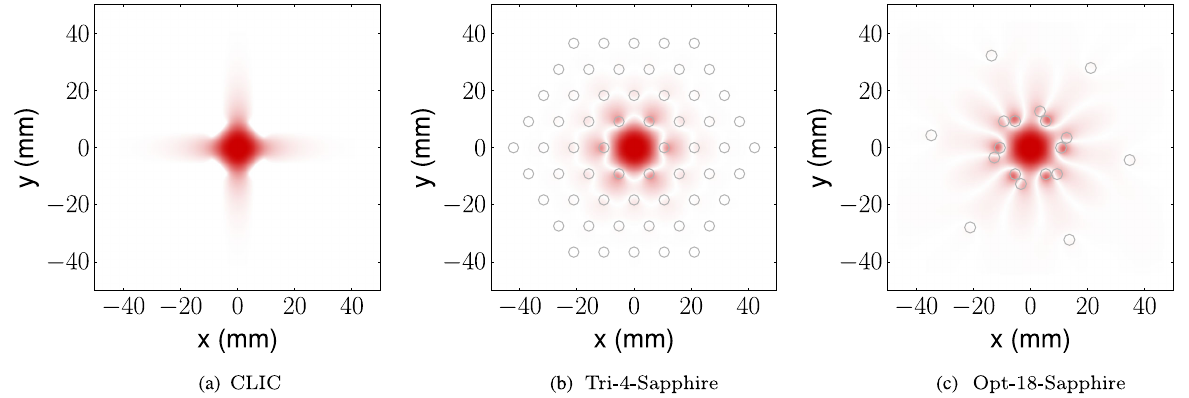
FIG. 17. Absolute value of E